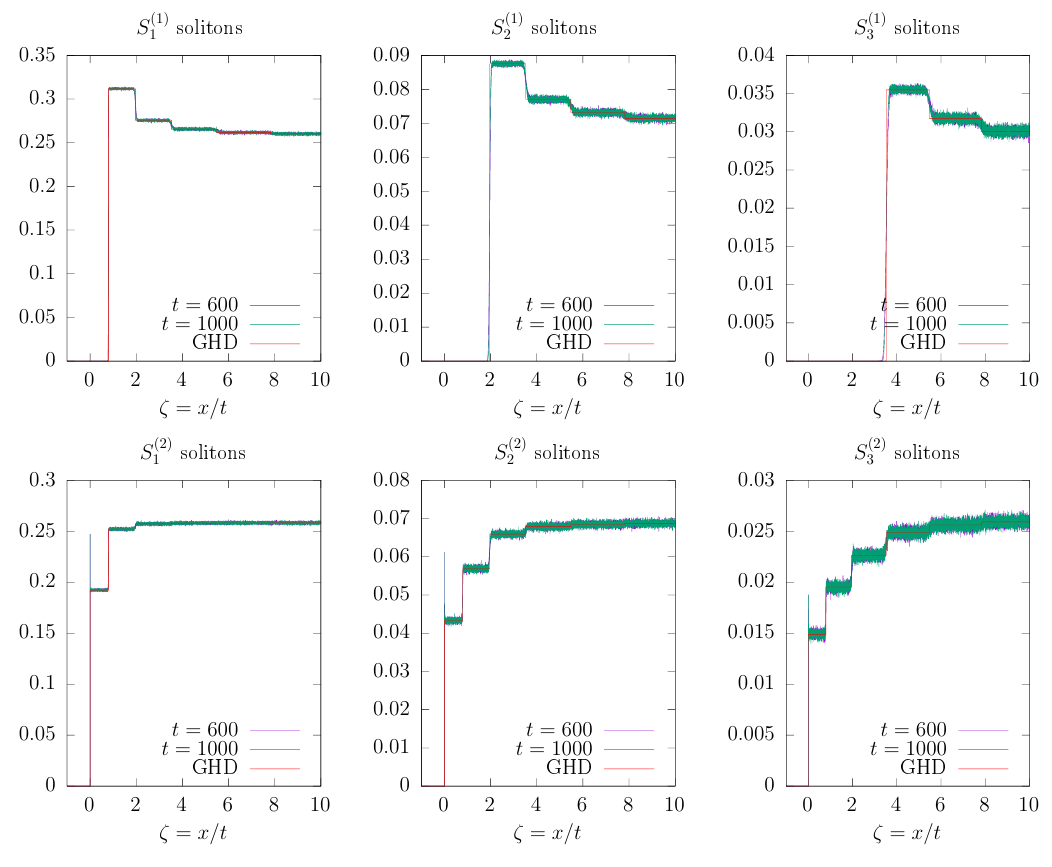
( a ) -soliton densities (with sizes k = 1 , 2 , 3 k . The initial ∞